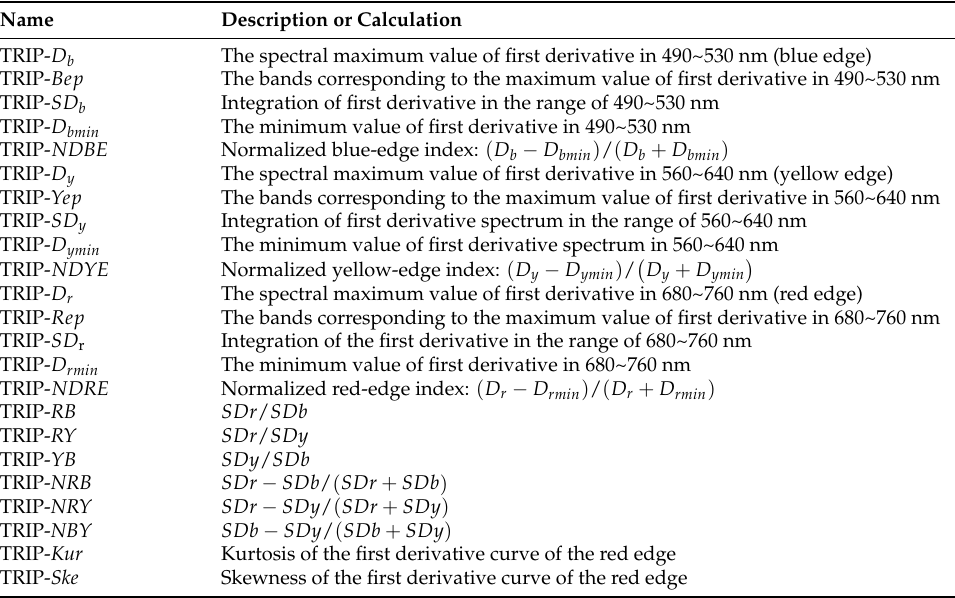
Table 2. The calculation formula of hyperspectral trilateral characteristic parameters.